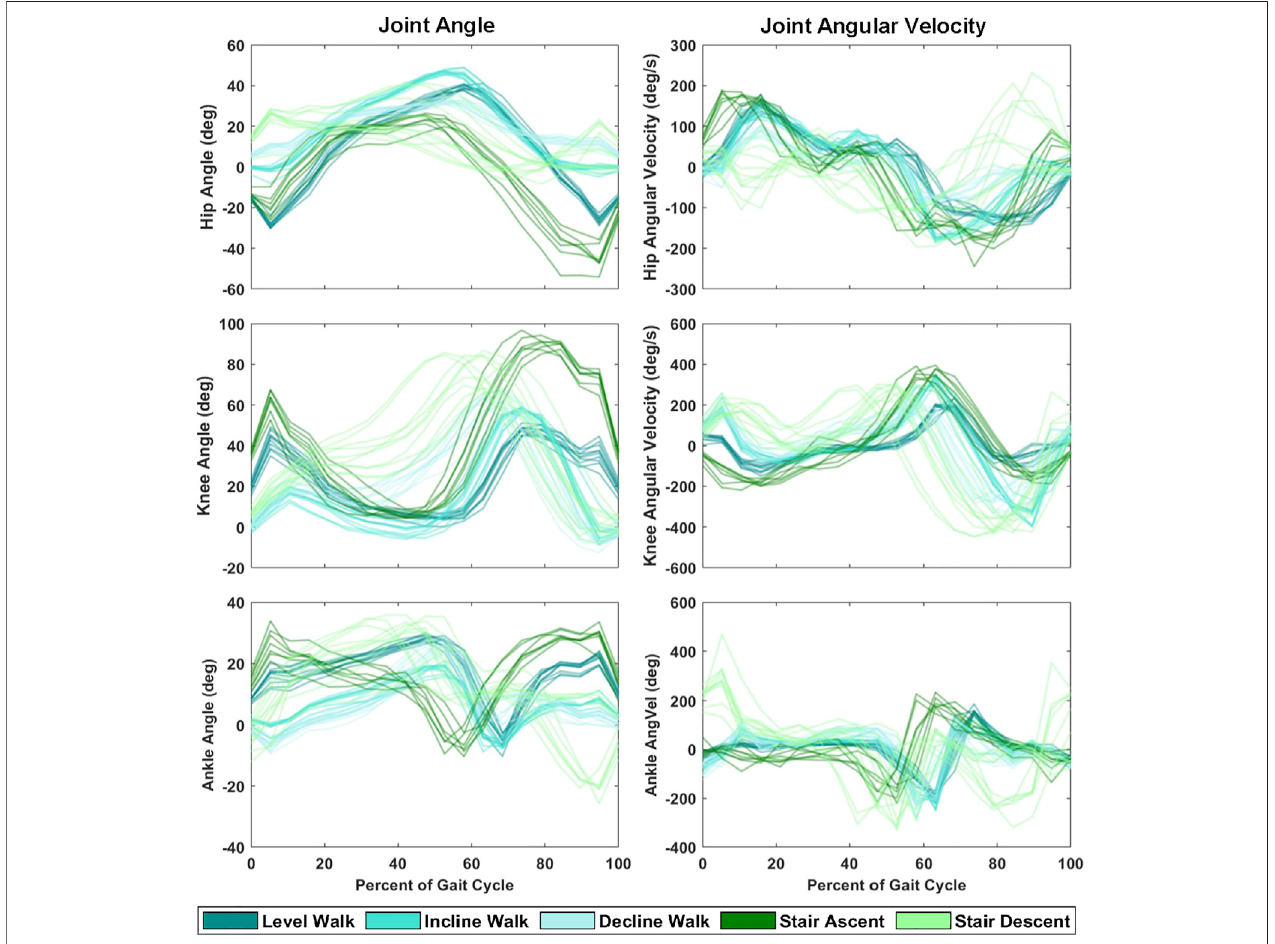
FIGURE 2 | Hip, knee and ankle joint angle and angular velocity during ten strides of each ambulation task (level walk, incline walk, decline walk, stair ascent and stair descent) from a single representative subject.